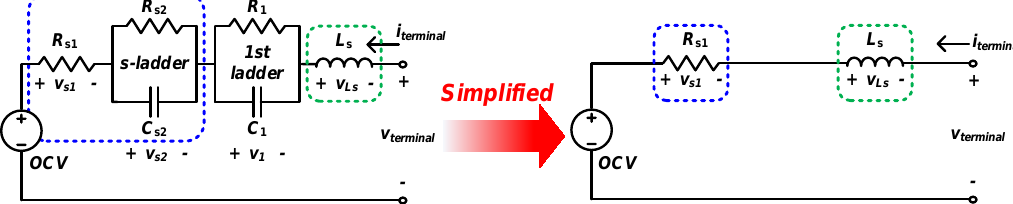
Figure 4. Proposed equivalent circuit model for state-of-function (SOF) estimation.